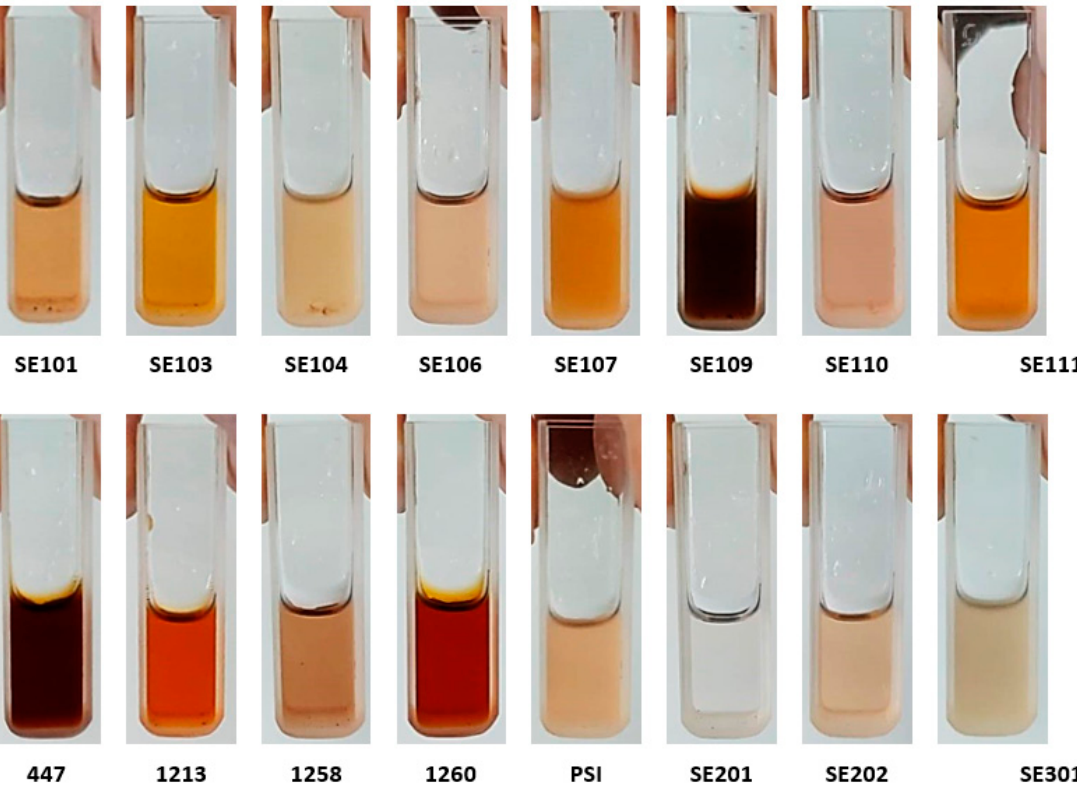
Figure 1. Colors of the synthesis reaction of silver nanoparticles with aqueous extracts of different entomopathogenic fungi.